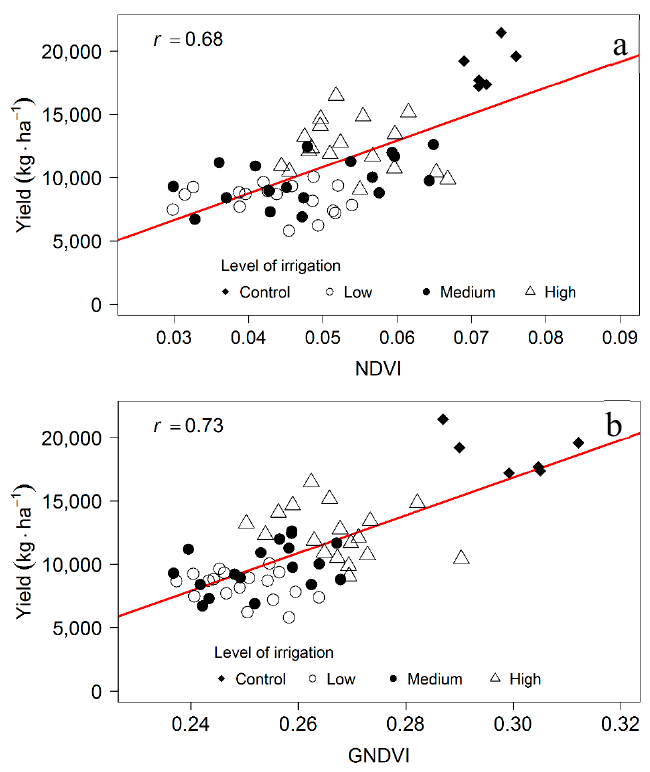
Figure 8. Correlations between ( a ) NDVI and ( b ) GNDVI data with the fruit yield at 44 DBH.